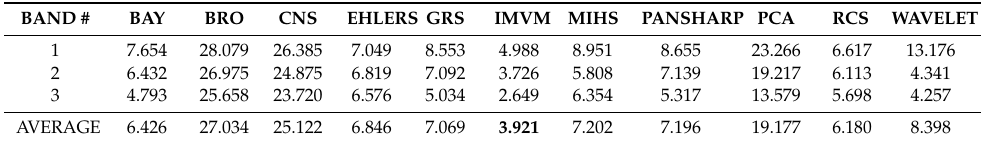
Table 9. Spectral synthesis: